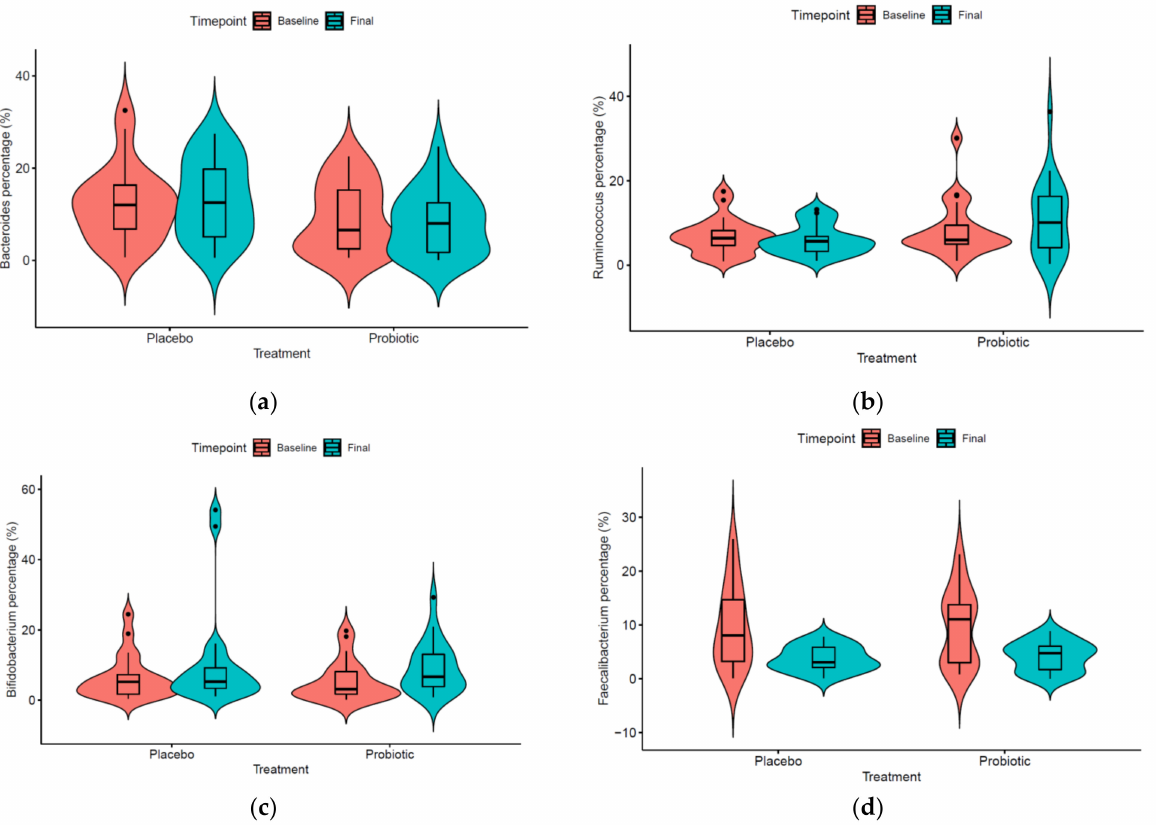
Figure 3. Violin plots showing significant genera comparing the placebo and probiotic groups’ evolution: ( a ) genus Bacteroides ; ( b ) genus Ruminococcus ; ( c ) genus Bifidobacterium ; ( d ) genus Faecalibacterium